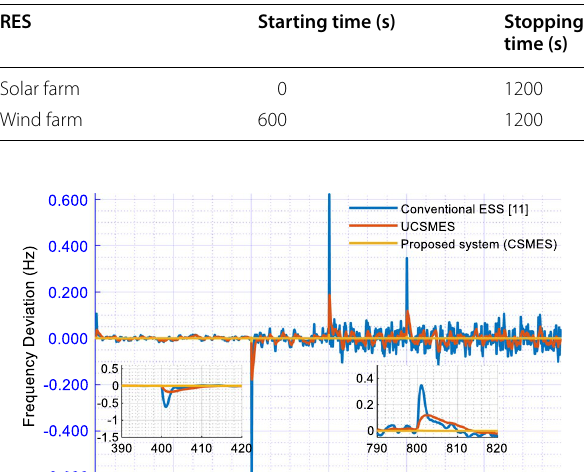
Table 5 Diverse operating circumstances of the µG for scenario